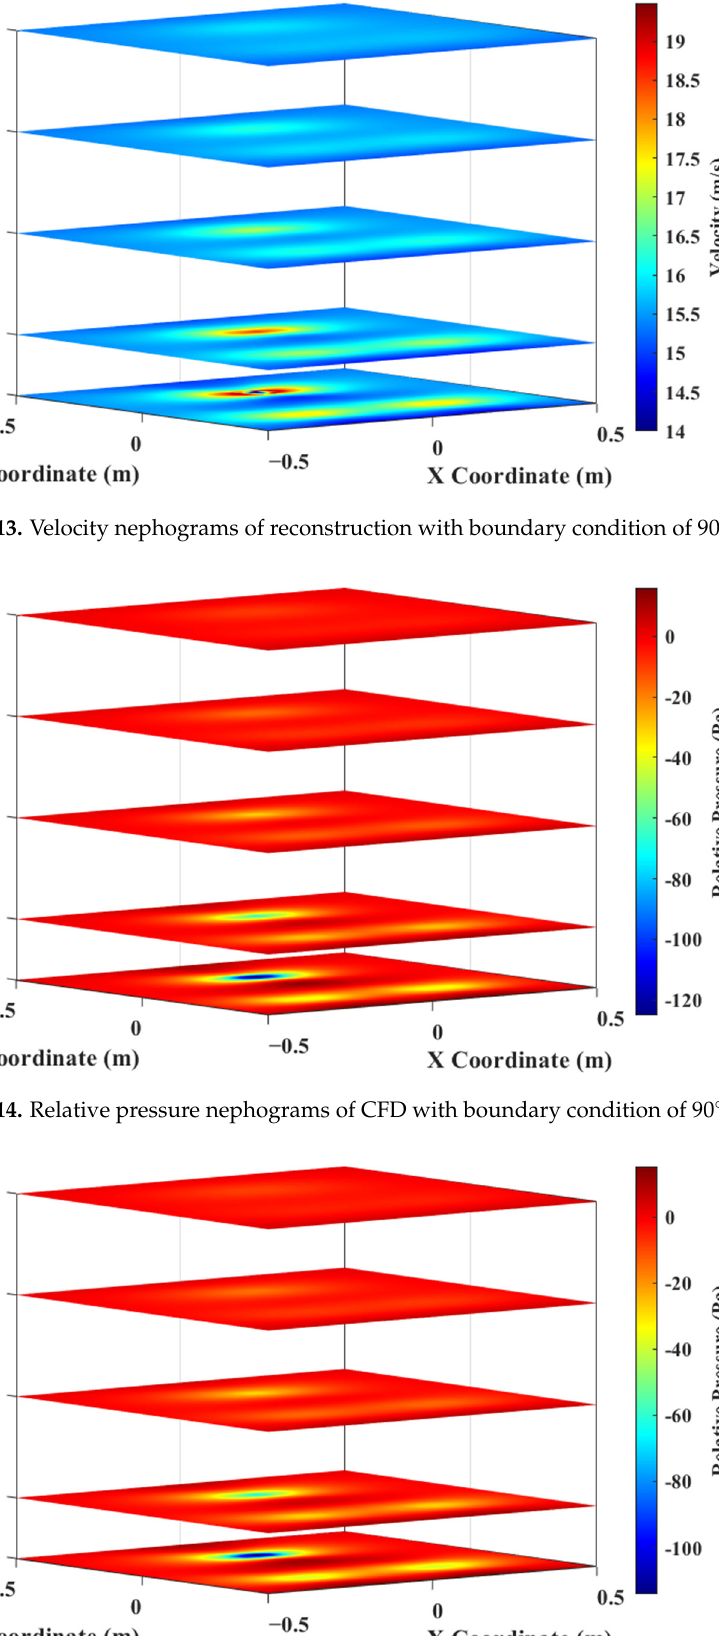
Figure 15. Relative pressure nephograms of reconstruction with boundary condition of 90°, 15 m/s.